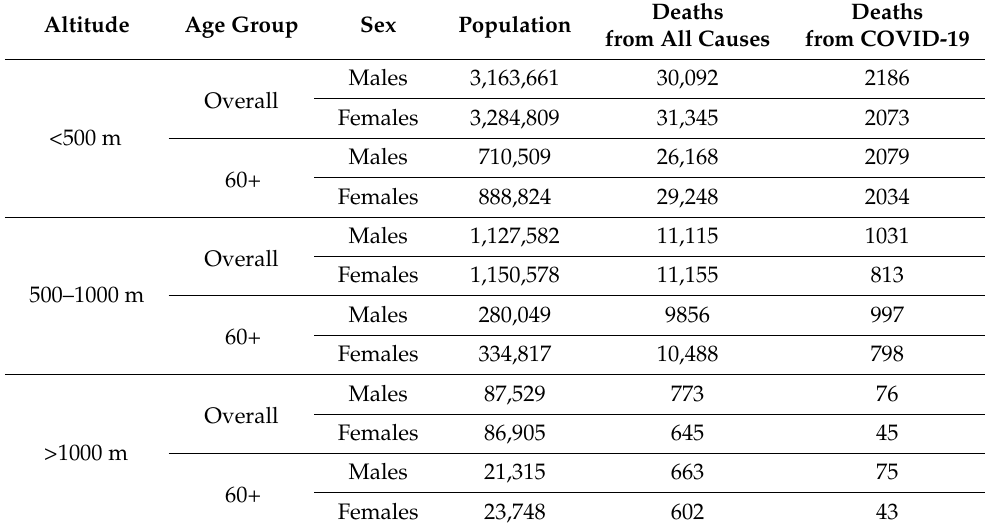
Overall COVID-19 MRs (per 100,000 of population in 2020) were 75.2 for males and 64.8 for females. A comparison of excess mortality between European countries in 2020 (on a monthly basis) can be obtained here: https://ec.europa.eu/eurostat/web/products-